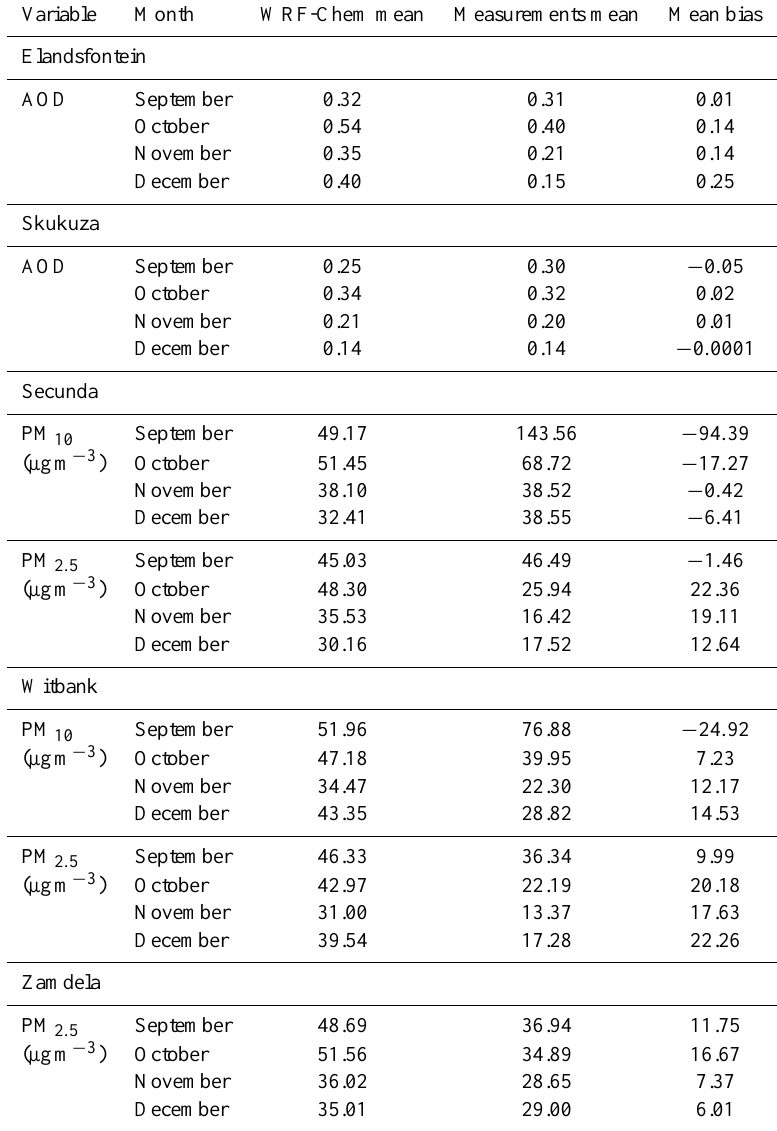
Table 3. Monthly mean and mean bias of modeled and observed AOD, PM 2 . 5 and PM 10